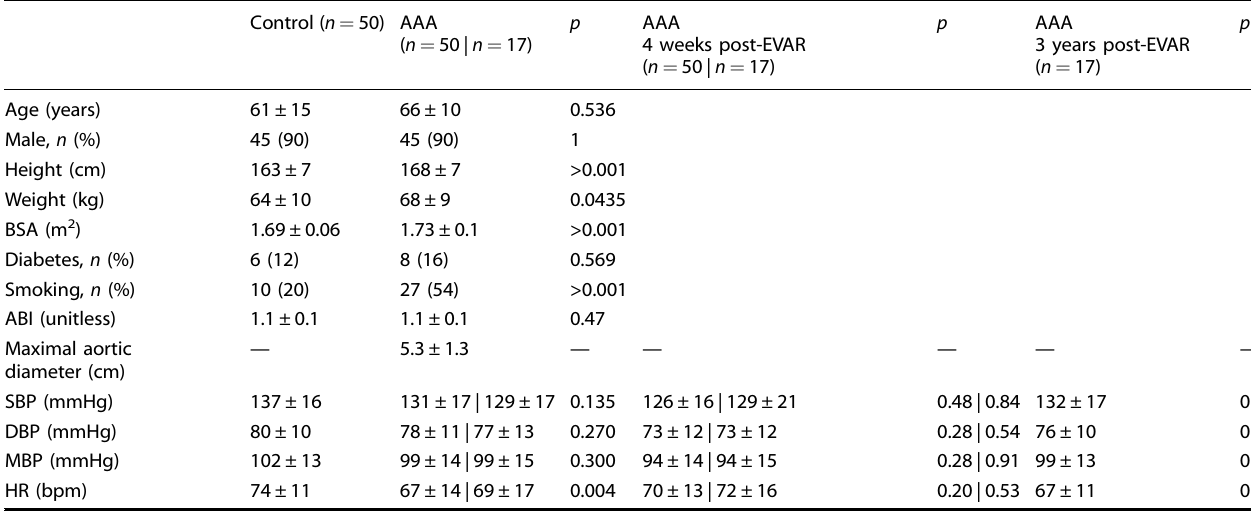
Table 1. Demographics, risk factors, and basic hemodynamic values of the abdominal aortic aneurysm (AAA) patients before and after endovascular repair (EVAR) and similar control